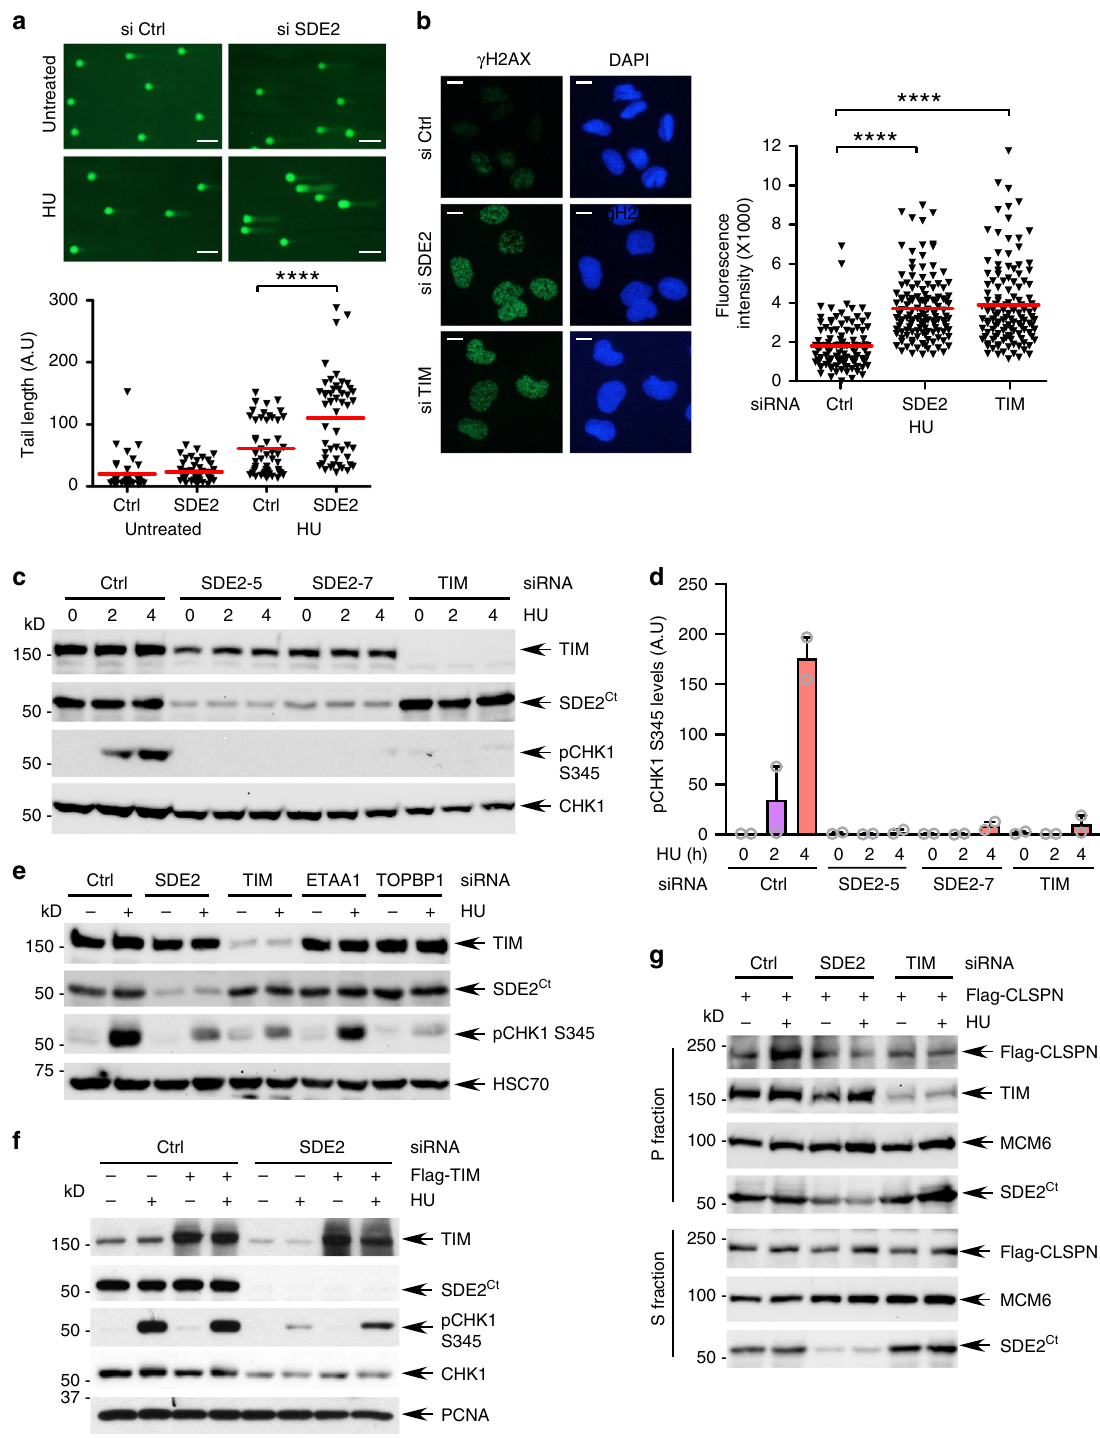
Fig. 5 SDE2 promotes CHK1 activation via TIM and CLSPN. a Top: representative images of DNA comets after treatment with 2 mM HU for 4 h in siRNA- transfected U2OS cells ( n = 2 biologically independent experiments). Scale bar, 50 μ m. Bottom: quanti fi cation of DNA comet tail lengths. Red bars represent the median (>50 nuclei per sample, **** P < 0.0001, Mann – Whitney test). b Left: representative images of γ H2AX staining after treatment with 2 mM HU for 4 h in siRNA-transfected U2OS cells ( n = 2 biologically independent experiments). Scale bar, 10 μ m. Right: Quanti fi cation of γ H2AX intensity. Red bars represent the median (>100 nuclei per sample, **** P < 0.0001, Mann – Whitney test). c CHK1 phosphorylation after treatment of 2 mM HU for the indicated times in siRNA-transfected U2OS cells. d Quanti fi cation of pCHK1 levels normalized by total CHK1. Mean from two biologically independent experiments is shown. e Comparison of pCHK1 induction in U2OS cells transfected with the indicated siRNAs. f Rescue of pCHK1 induction in U2OS